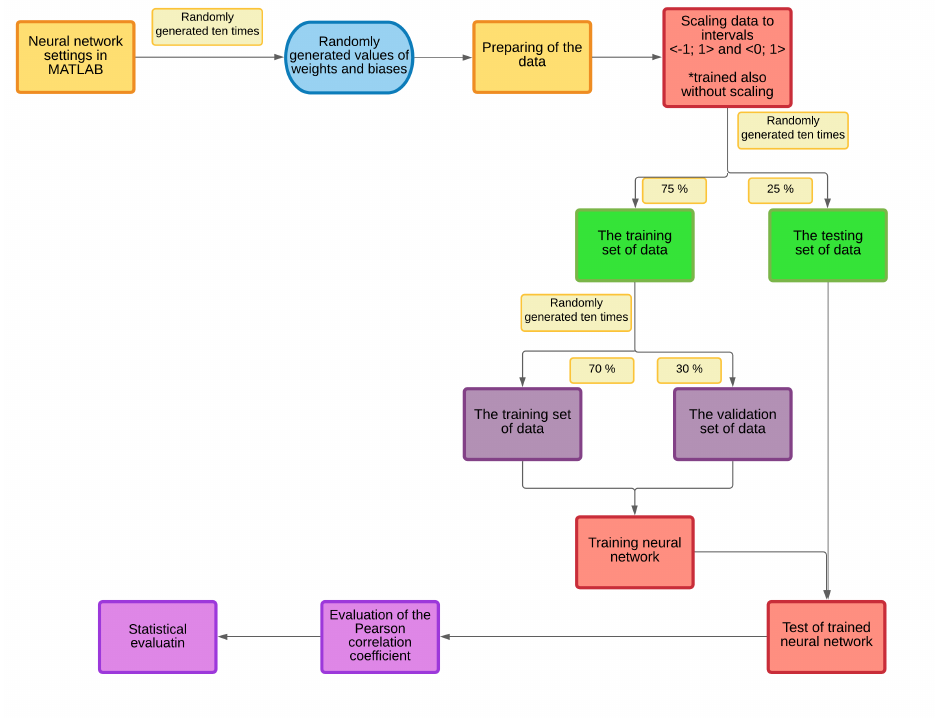
Figure 18. The process of creating the neural